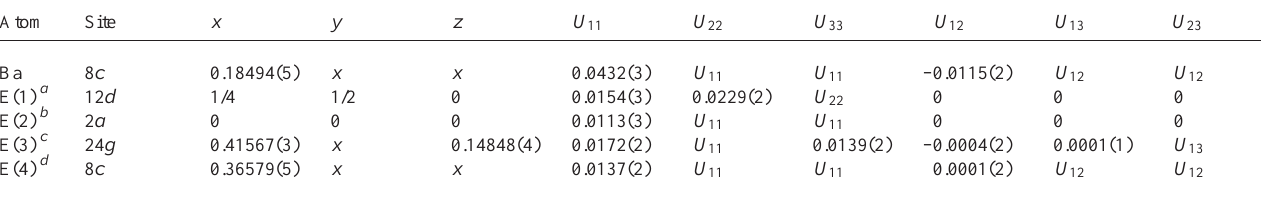
Table 2. Atomic coordinates and displacement parameters (in Å 2 )